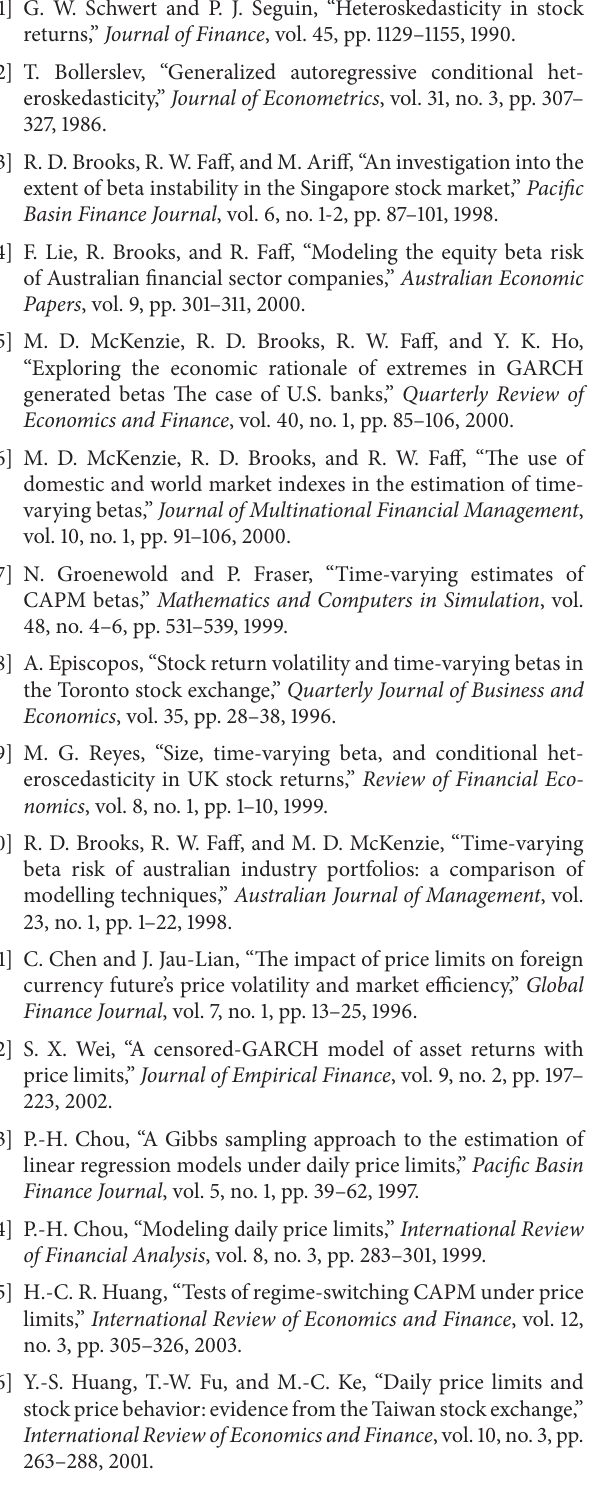
the effectiveness of Censored-SS market model. The main conclusions are as